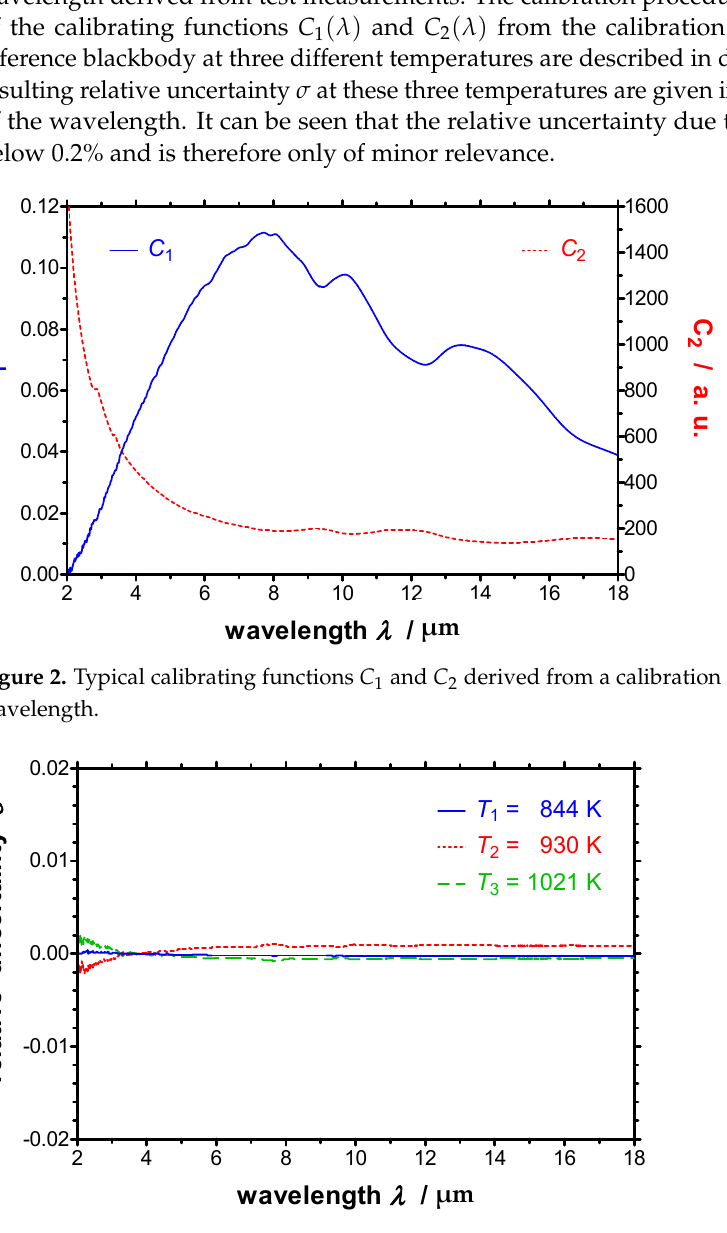
Figure 3. Spectral relative uncertainty of the calibration of the improved EMMA for three calibration temperatures T 1 , T 2 and T 3 .